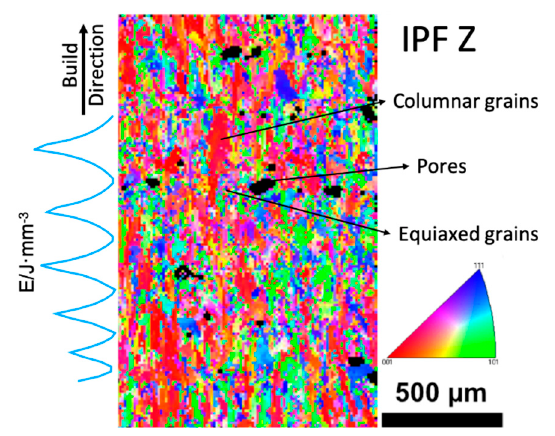
Figure 3. EBSD pattern of the x-z section.